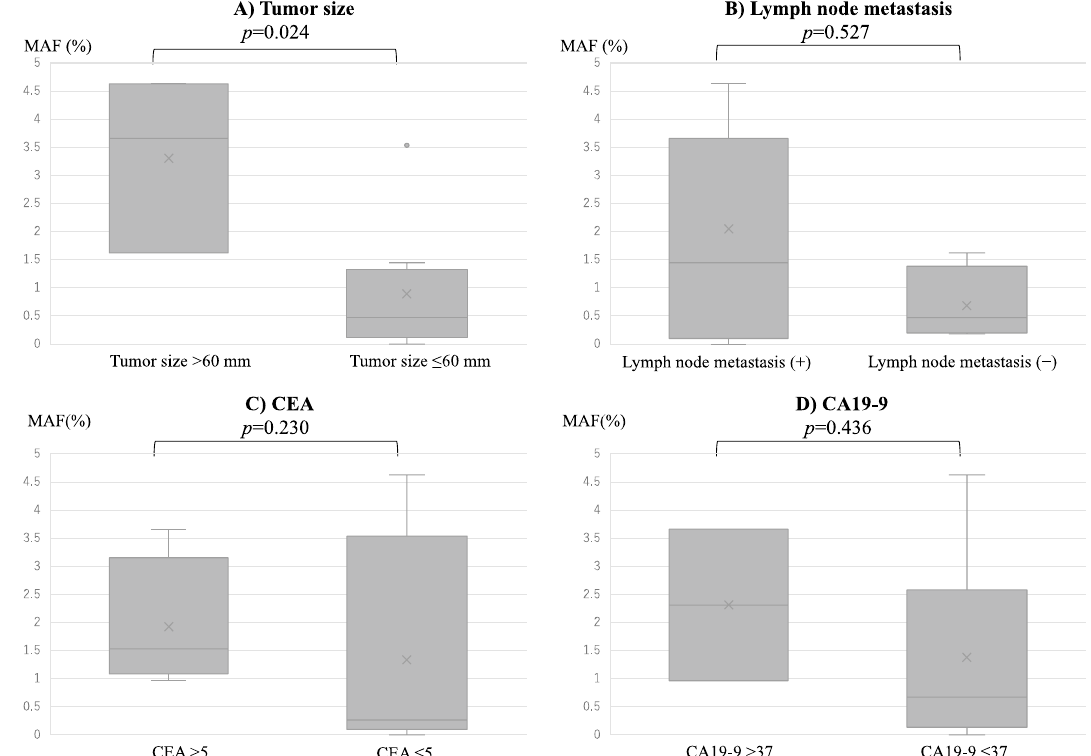
Figure 4. Relationship between preoperative BRAF V600E mutant allele frequency and tumor size, lymph node metastasis, and tumor markers. ( A ) Tumor size, ( B ) lymph node metastasis, ( C ) CEA, and ( D ) CA19-9. Pairwise level. (Mann–Whitney U test; p = 0.527, p = 0.230, and p = 0.436, respectively.)